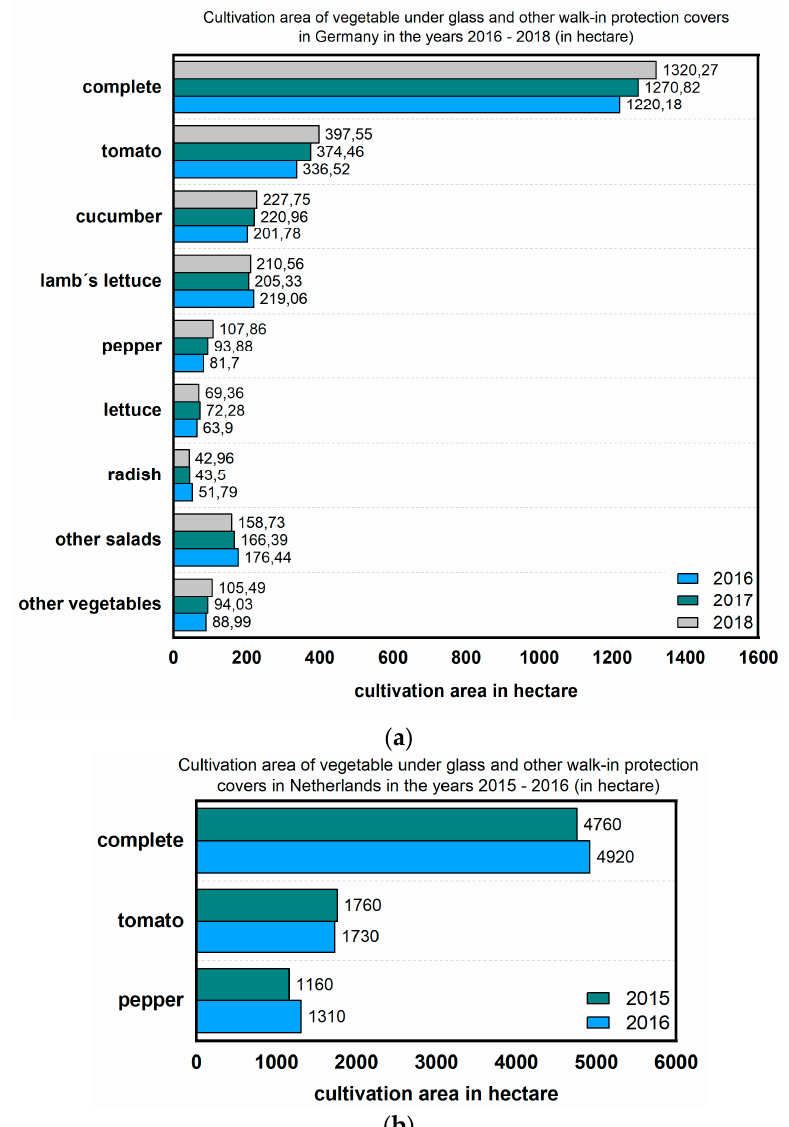
Figure 4. Statistical analyses of the greenhouse cultivation areas: ( a ) development of vegetable cul- tivation under glass in Germany in the years 2016–2018 Reproduced from [11], Publisher: Statistisches Bundesamt; ( b ) development of vegetable cultivation under glass in the Netherlands in 2015–2016 Reproduced from [12], Publisher: Statista Research